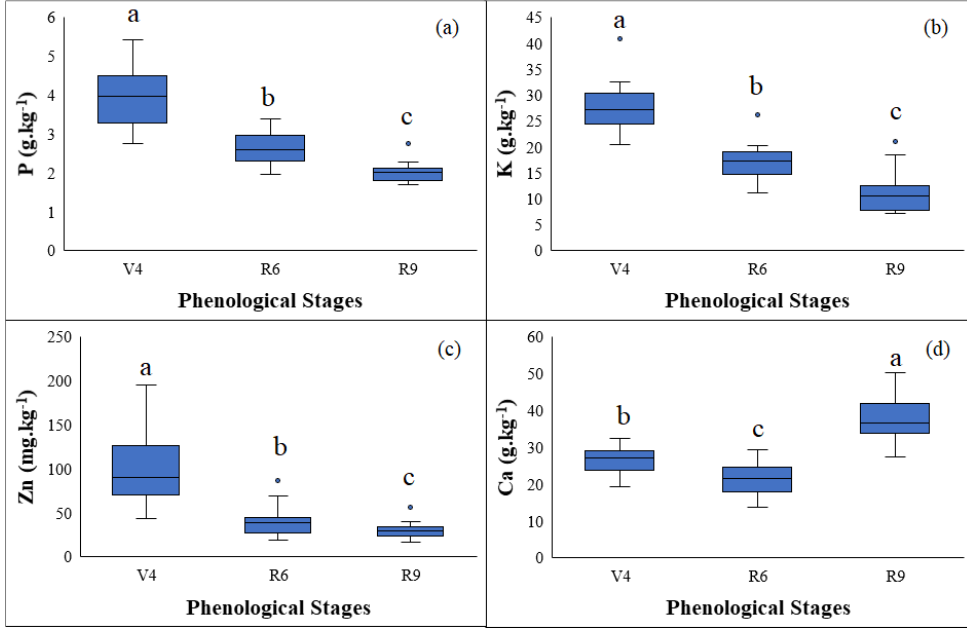
Figure 4. Nutrient content: phosphorus ( a ), potassium ( b ), zinc ( c ) and calcium ( d ) in the leaves of Vigna unguiculata (L.) Walp. Different letters indicate a statistical difference by Tukey’s test at 5% probability.